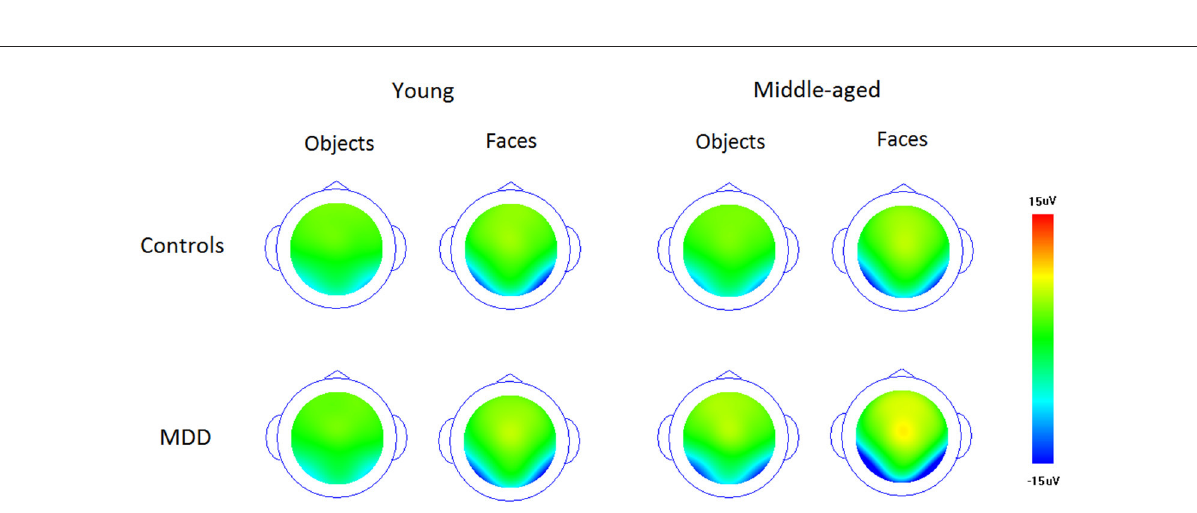
FIGURE3 The voltage topography of N170 elicited by upright faces and objects in patients and controls, respectively.